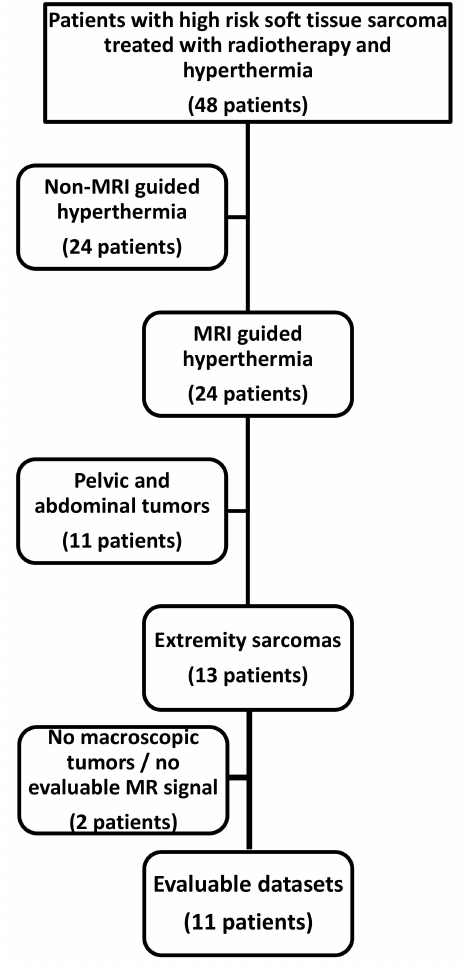
Figure 1. Of 48 patients registered in the prospective database of our institution of soft tissue sarcoma patients treated with radiotherapy and locoregional hyperthermia ± chemotherapy, 11 datasets were identified with neoadjuvant treatment of lower extremity tumors treated with MR-guided hyperthermia, which then were used for the